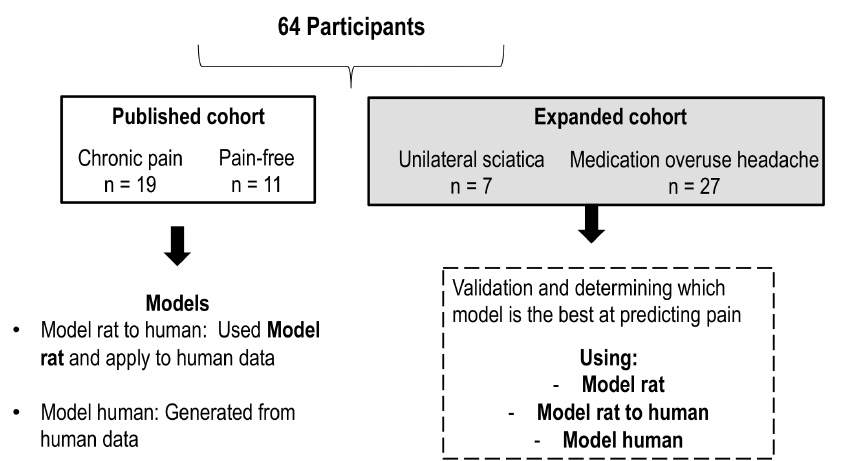
Figure 3. Overview of the generation and comparison of models generated from post graded CCI rats and humans (chronic pain and pain-free